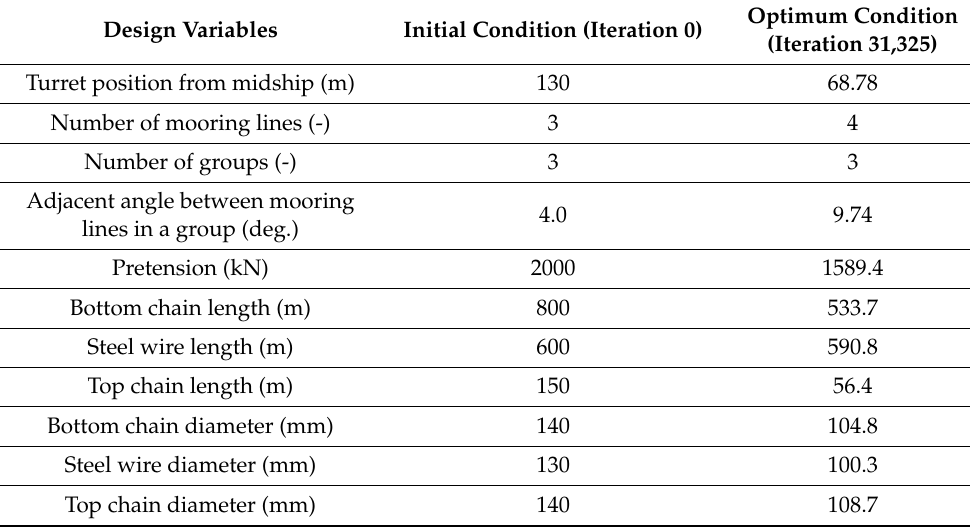
Table 8. The results of mooring system optimization for case B.